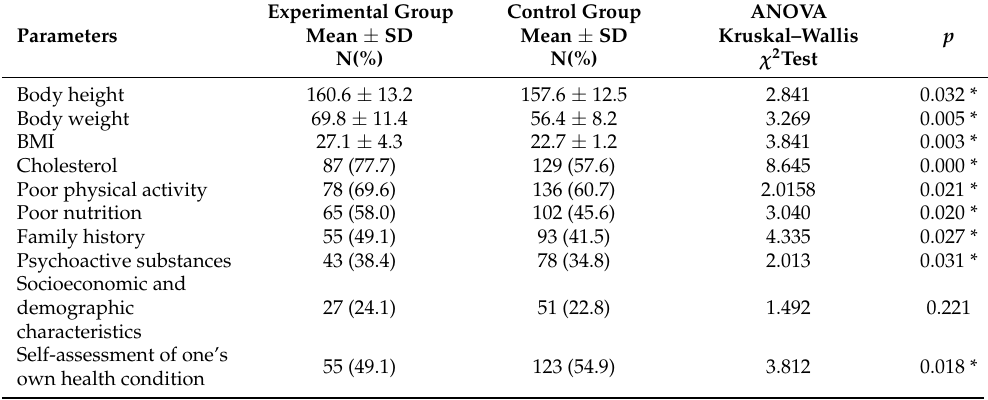
Table 7. Analysis of parameters that indicate the existence of hyperinsulinemia.